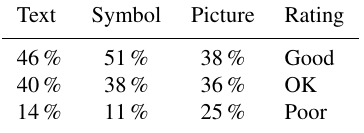
Table 5. Results from the test of what communicates the avalanche problem best in the avalanche warning. Text Symbol